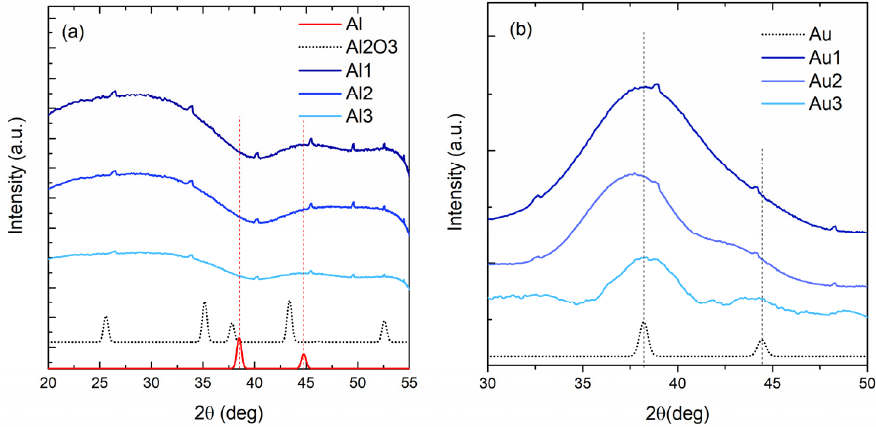
Figure 3. Grazing-incidence wide angle X ray scattering (GIWAXS) measurements of the ( a ) Al- and ( b ) Au-based films. The tiny peaks with similar shapes, visible in most of the curves, are detector artefacts.